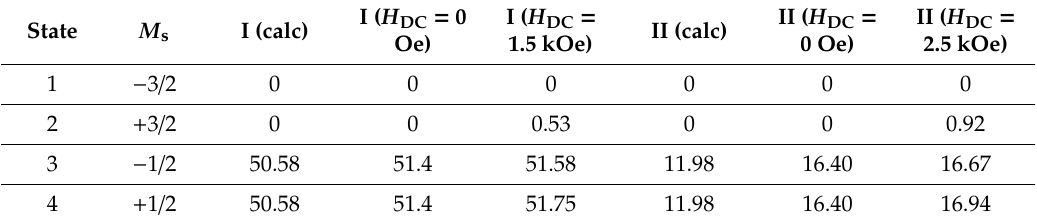
Table 3. Energy levels (cm − 1 ) for I and II from Hamiltonian (1) approximation of the temperature dependences and CASSCF / NEVPT2